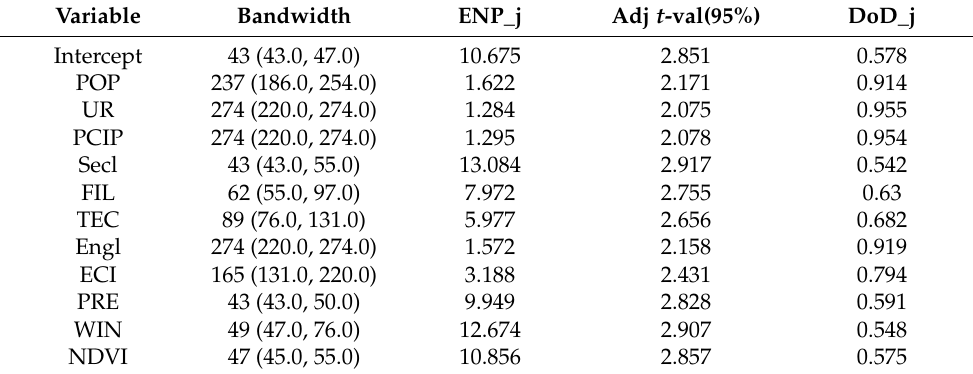
Table A2. MGWR bandwidths (bandwidth confidence intervals: 95%).